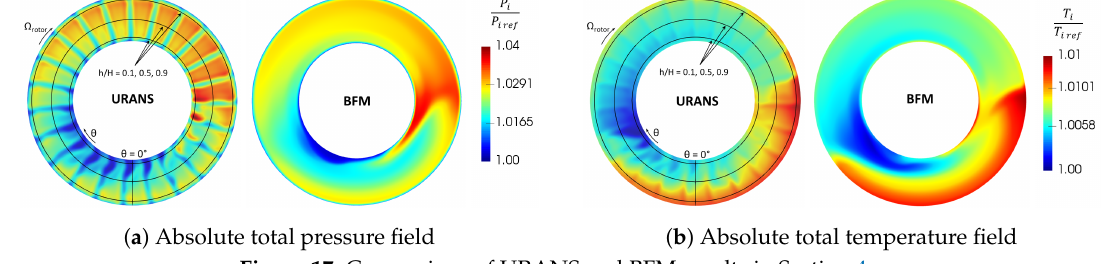
Figure 17. Comparison of URANS and BFM results in Section 4.